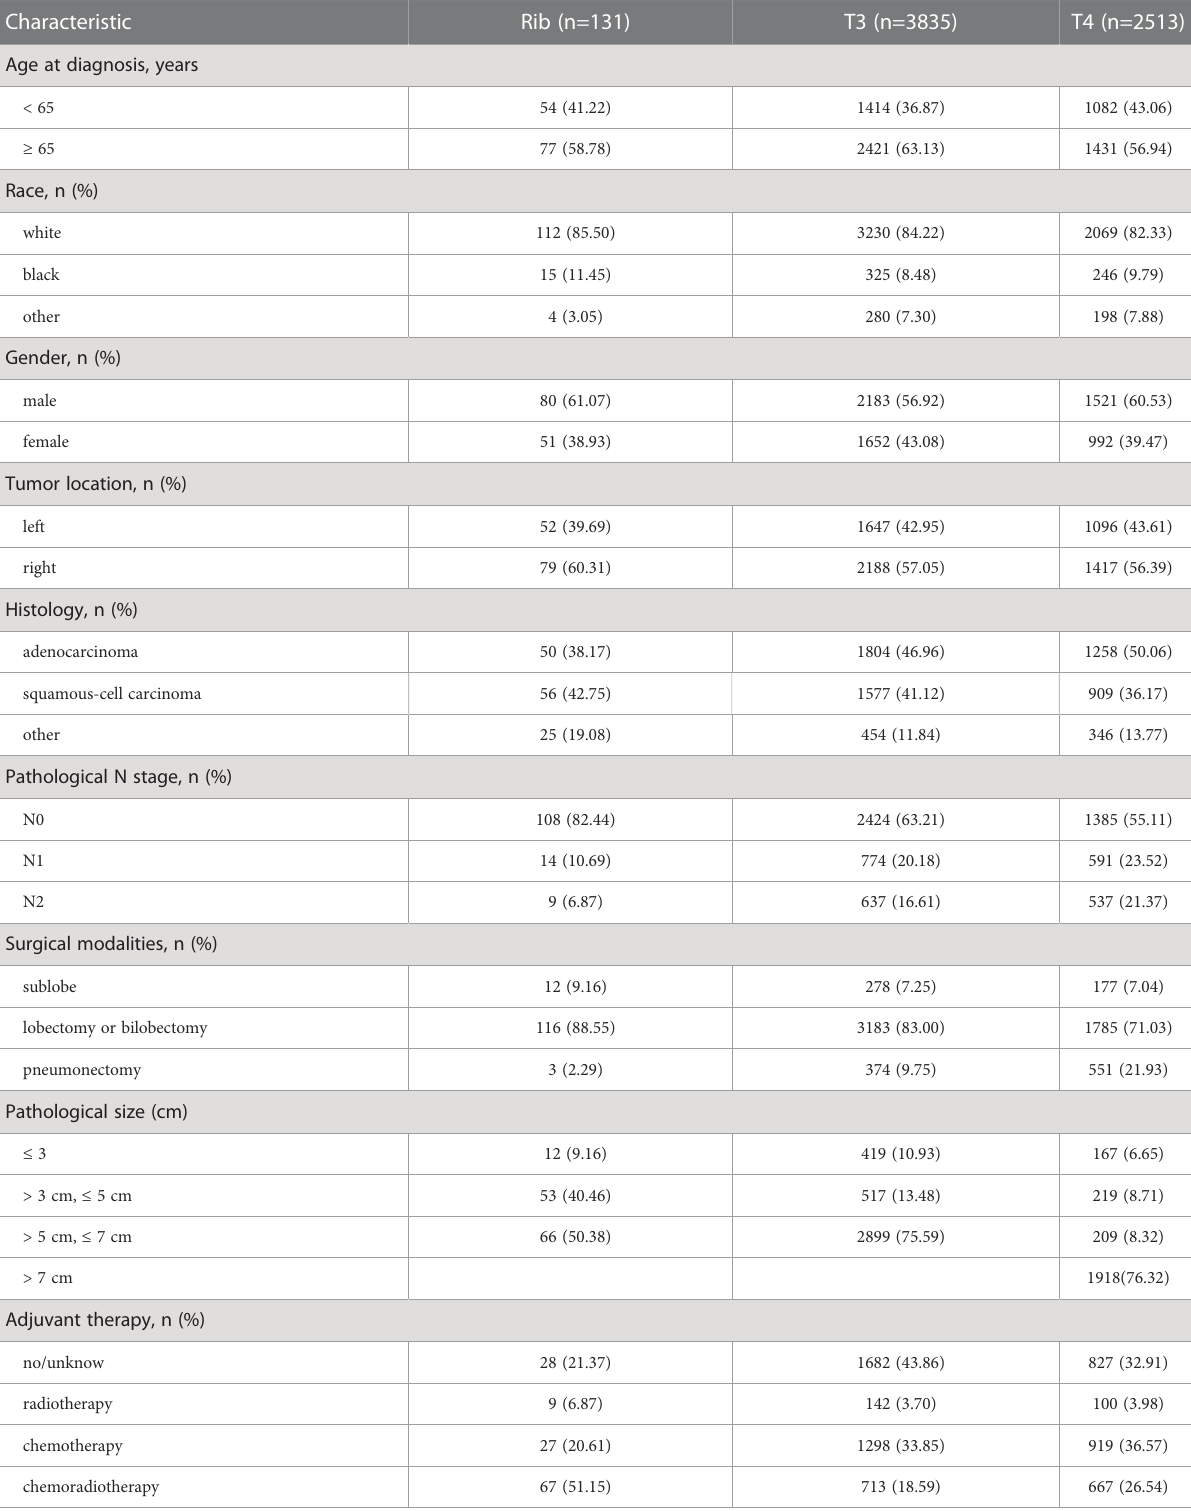
TABLE 1 Clinical characteristic of patients pathological T3-4 NSCLC (N=6479).